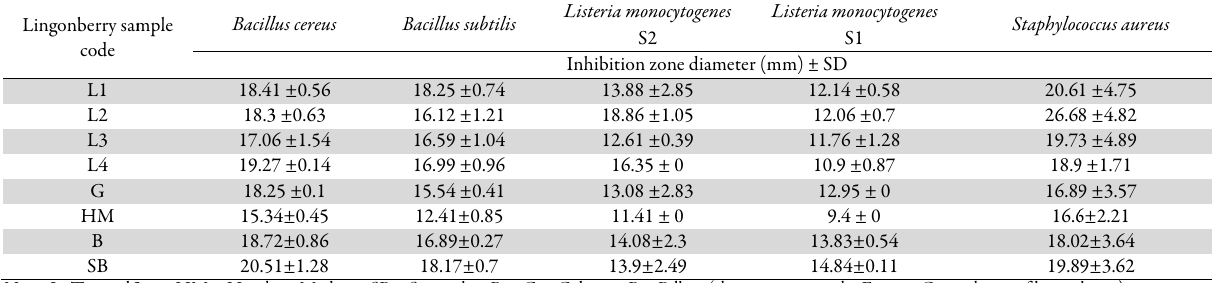
Table 2. Antimicrobial effect of lingonberry samples on Gram Lingonberry sample